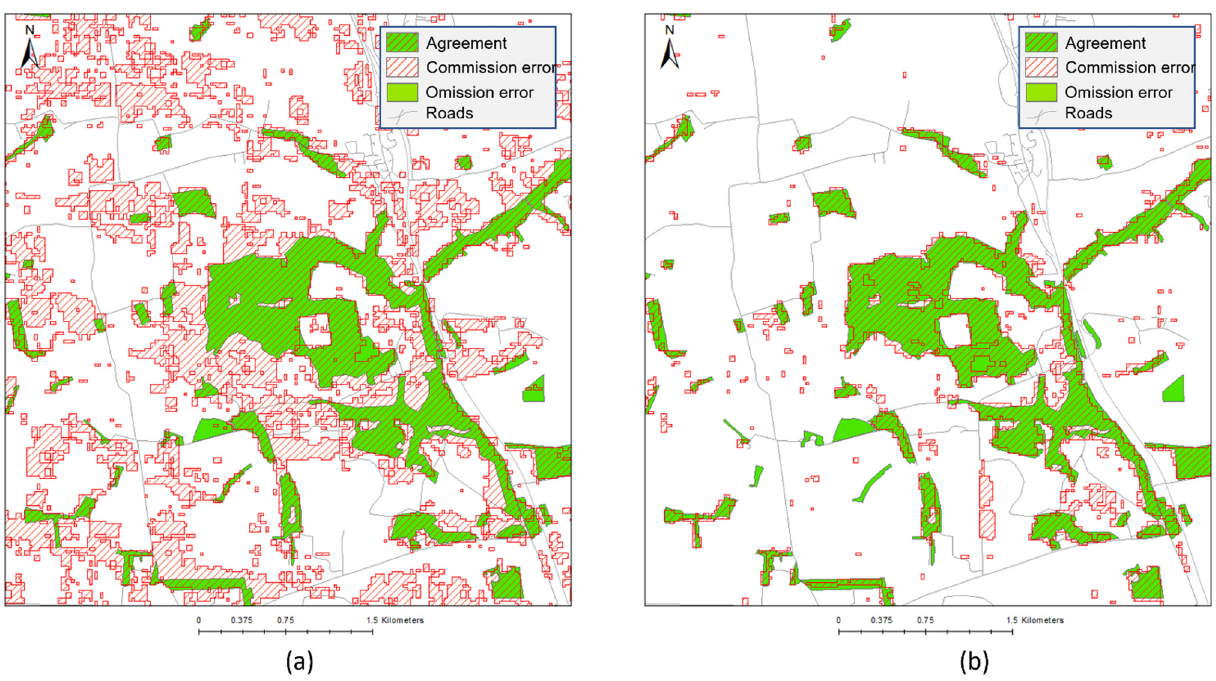
Figure 3. Accuracy maps for ( a ) 2010 NFI (reference in green) vs. 2010 GLAD FC, ( b ) 2010 NFI vs. 2000 GLAD FC. (location within the UK the same as Figure 2).